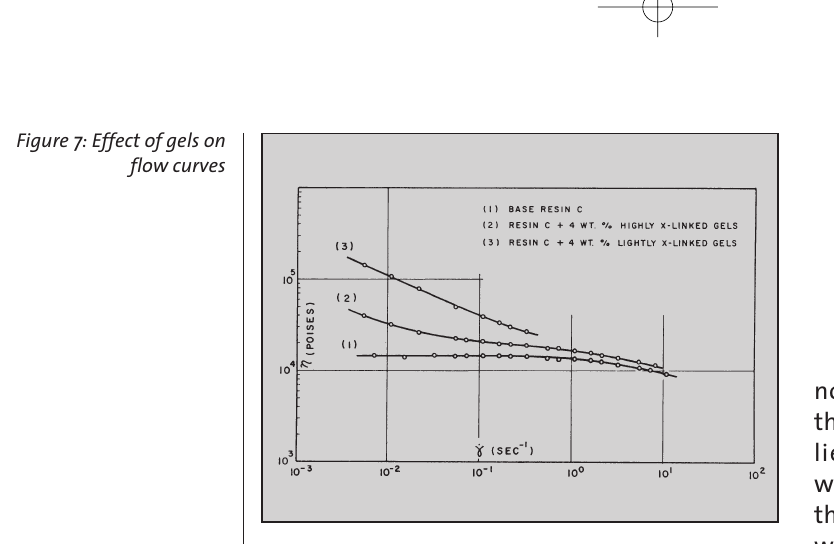
AR • Vol 9 • Nr 3 neu 19.04.2000 9:58 Uhr Seite